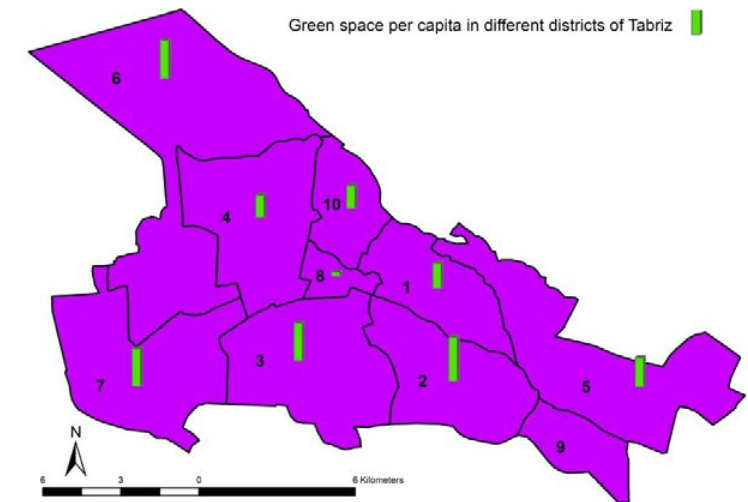
Fig. 6: Per capita urban green space supply in the municipal districts Fig 6: Per capita urban green space supply in the municipal districts